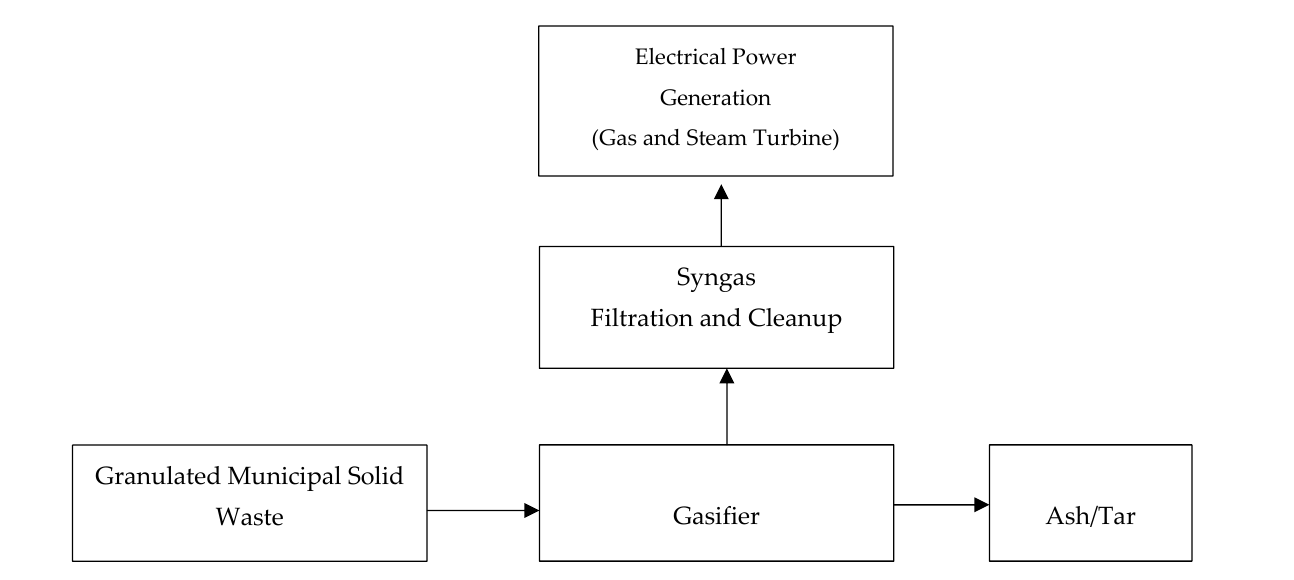
Figure 3. Solid waste gasification process.